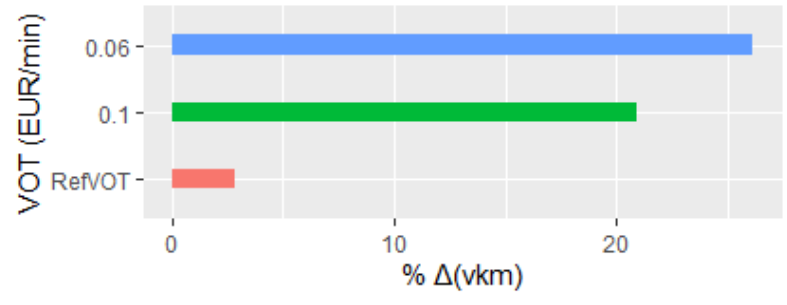
Figure 5. Percentage changes in car km compared to the reference scenario